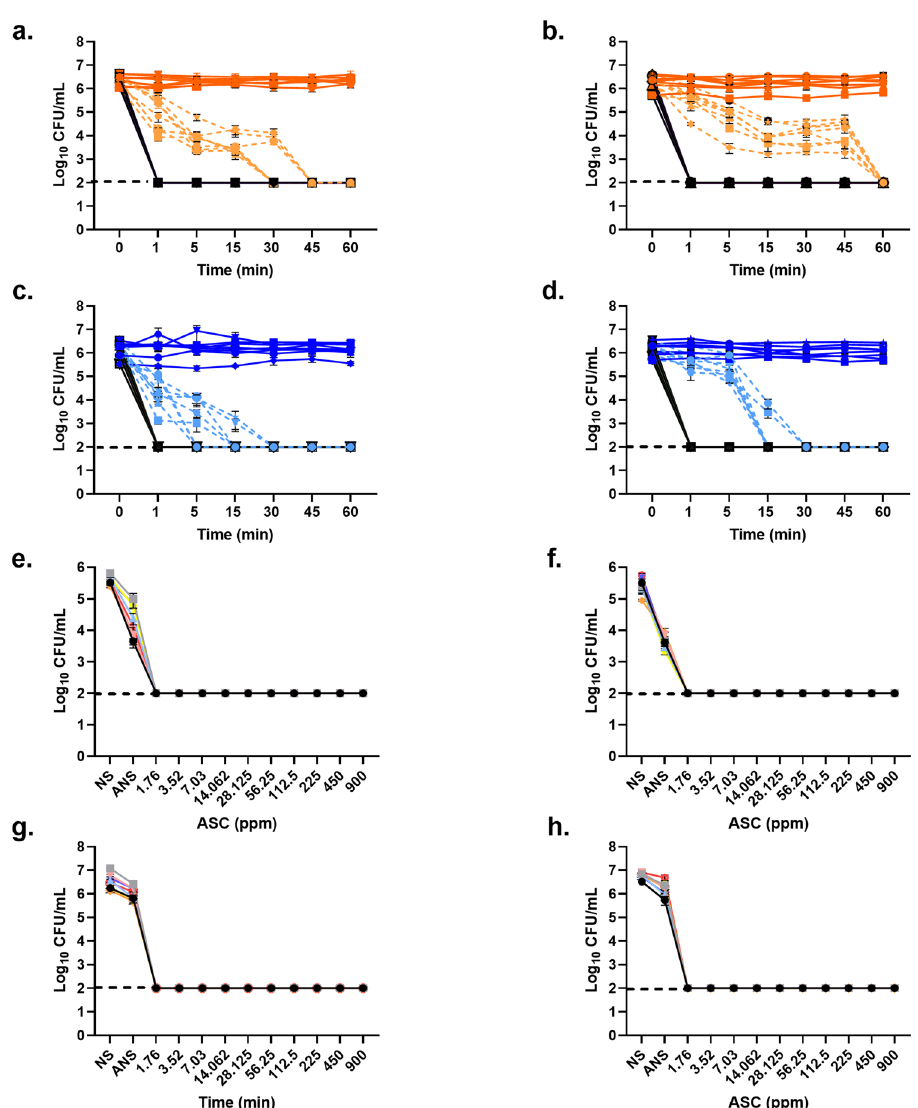
Fig. 1 Bactericidal kinetics of C. jejuni with ASC. In time-kill assays ( a , b , c , d ), ATCC C. jejuni 33221 and seven chicken meat isolated C. jejuni were exposed to ASC (900, 450, 225 ppm) for 60 min. Broth control (dark orange lines), acidi fi ed broth control (light orange hash lines), 0.9% saline control (dark blue lines), and acidi fi ed 0.9% saline control (light blue hash lines) were compared with ASC treated groups (black lines). Temperature effect was compared at 5 °C ( a , c ) or 25 °C ( b , d ). In inactivation assays ( e , f , g , h ), the same C. jejuni isolates with ATCC strain were exposed to ASC (1.76 – 900 ppm) for 1 min. Inactivation kinetics were determined for both 10 6 CFU/mL ( e , f ) at 5 °C ( e ) and 25 °C ( f ) and the 10 8 CFU/mL ( g , h ) at 5 °C ( g ) and 25 °C ( h ). Data are presented as mean log 10 CFU/mL ± SEM. The dotted line indicates the limit of detection of culturable bacteria. (NS; 0.9% saline, ANS; acidi fi ed 0.9%